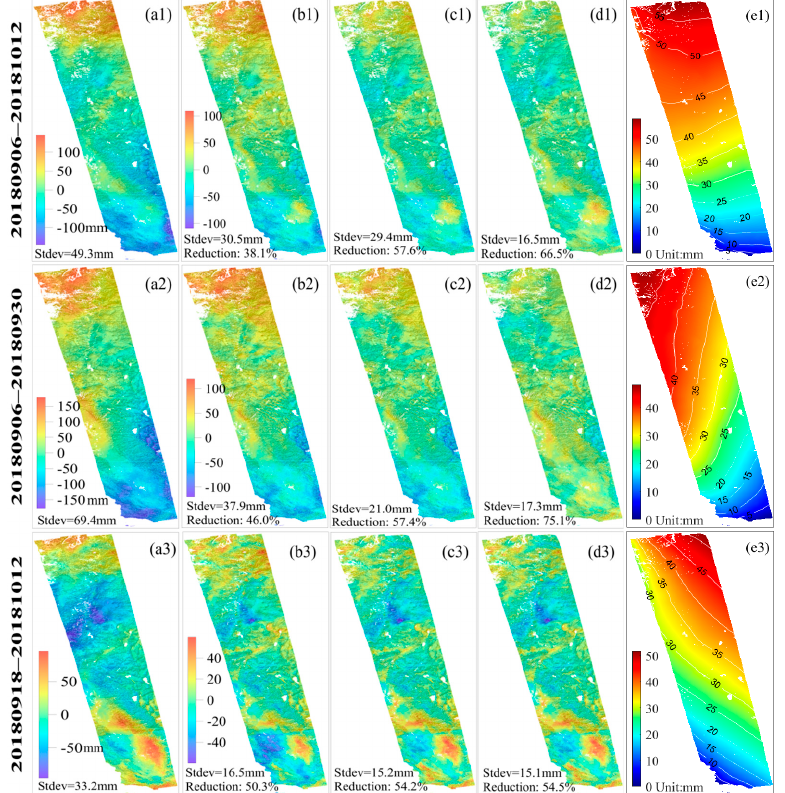
Figure 8. ( a1 − a3 ) The long-strip differential interferograms after the correction of ( b1 − b3 ) atmos- pheric delay error, ( c1 − c3 ) SET and OTL, and ( d1 − d3 ) bilinear ramp elimination. ( e1 − e3 ) The SET and OTL displacements, whose spatial trend variations are similar to the long-strip differential in- terferograms after the atmospheric delay is corrected. By analysing the long-wavelength signals of the long-strip differential interferogram in the results in Figure 8, the atmospheric delay is the most vital component in the long- strip differential interferogram, but its magnitude is independent of the spatial scale of the differential interferogram, and the OTL displacement increases with the spatial cover range of the differential interferogram. Therefore, the SET and OTL effects have become the major signals in large-range differential interferograms in coastal areas. The topogra- phy-related signal in the long-strip differential interferogram corrected by the atmos- pheric correction algorithm is weakened, and the StdDev values of the differential inter- ference diagram are reduced by 38.1~50.3% (Figure 8(b1 − b3)). The spatial trend signal in the long-strip differential interferogram with the atmospheric delay correction is similar to the tidal displacement of the SET and OTL effects (Figure 8(e1 − e3)). Further correction of the SET and OTL displacements further reduces the StdDev value of the differential interferogram by 3.9~19.3% (Figure 8(c1 − c3)), and its magnitude depends on the relative spatial variation in the ground tidal displacement. The residual large-scale signal in the long strip differential interferograms is inconsistent with the spatial characteristics of the OTL and approaches the linear plane, which can be eliminated using a bilinear fitting function (Figure 8(d1 − d3)). After that, the trend signal in the long-strip differential inter- ferogram is basically eliminated.